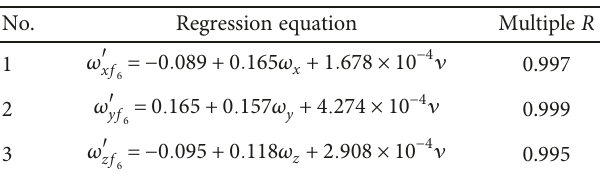
Figure 14: Fitting polynomial and surface fi tting results of liquid storage tank and microsatellite with the deployment mechanism for (a) ω ′ , and (c) ω ′ . (b) ω yf zf 6 6 ′ , ω ′ , and ω ′ of the surface regression equations. Table 21: ω xf 6 yf 6 zf 6 No. Regression equation Multiple